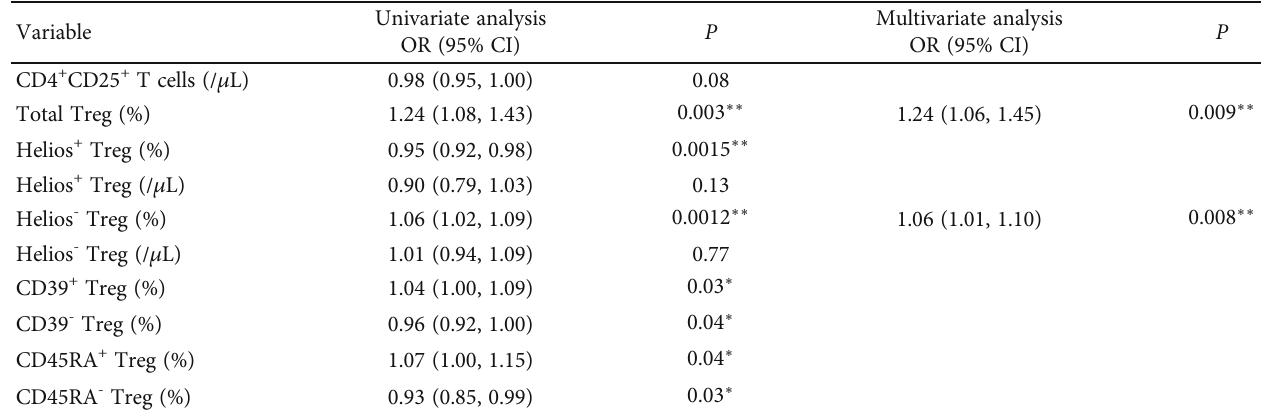
Table 7: Risk factors of Treg subpopulations for progression by logistic